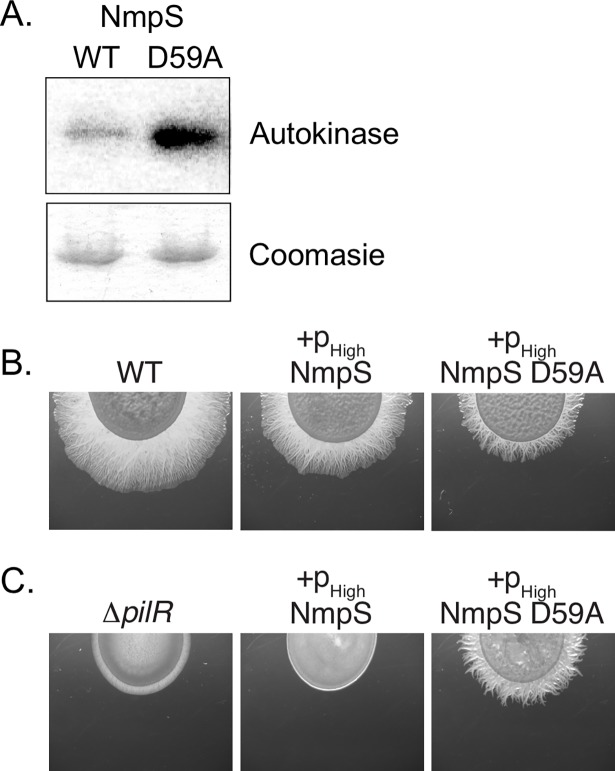
The conserved aspartic acid of the response regulator domain of NmpS is not necessary for kinase activity.(A) Full-length wild-type NmpS and a construct in which the conserved aspartic acid was substituted with an alanine (D59A) were used in an autokinase assay as in Fig 6. The aspartic acid residue was not necessary for activity, supporting the conclusion that the unphosphorylated form of NmpS is the active state. A Coomasie stained gel is included demonstrating the same amount of kinase was in each reaction. (B and C) M. xanthus wild-type or the ΔpilR strain were transformed with NmpS or NmpS D59A over-expression constructs and only the NmpS D59A construct was able to rescue motility of ΔpilR. This again is consistent with the in vitro kinase activity (A) that supports the conclusion that the unphosphorylated form of NmpS is active.